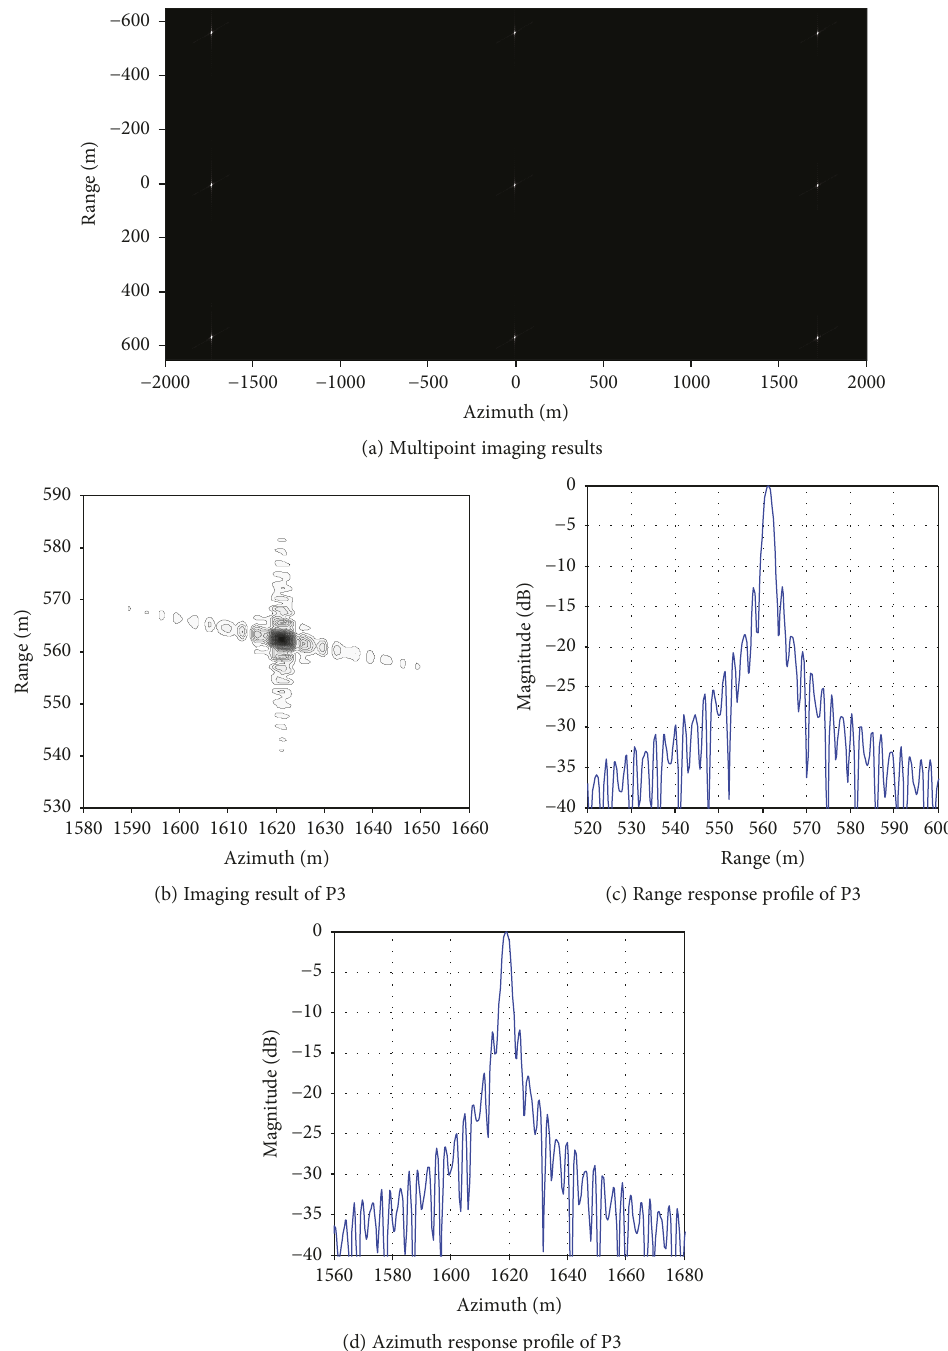
Figure 8: Imaging results in the TOPS mode of the